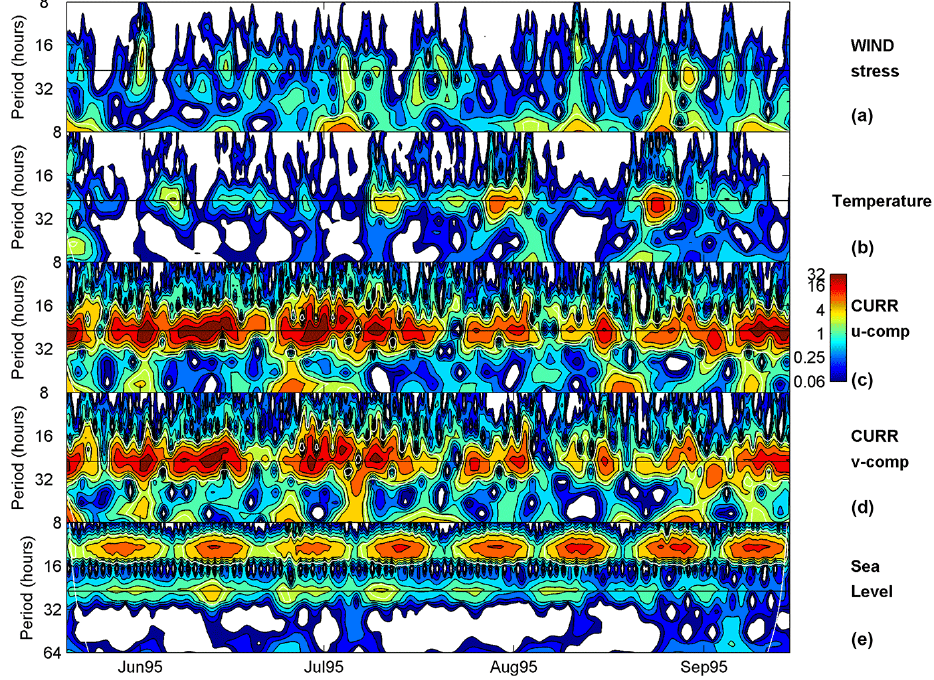
Fig. 12. Wavelet spectrum as a function of time and scale (period) for wind stress (a) , temperature (b) and residual bottom current components (c and d) at St2, and sea level at Otranto (e) during summer 1995. Diurnal scale (24h) is indicated by a horizontal black